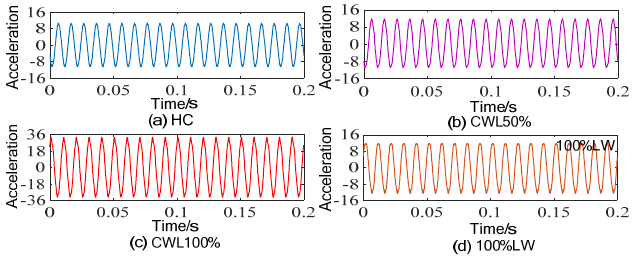
Figure 17. Vibration signal waveform of measuring point No. 23.